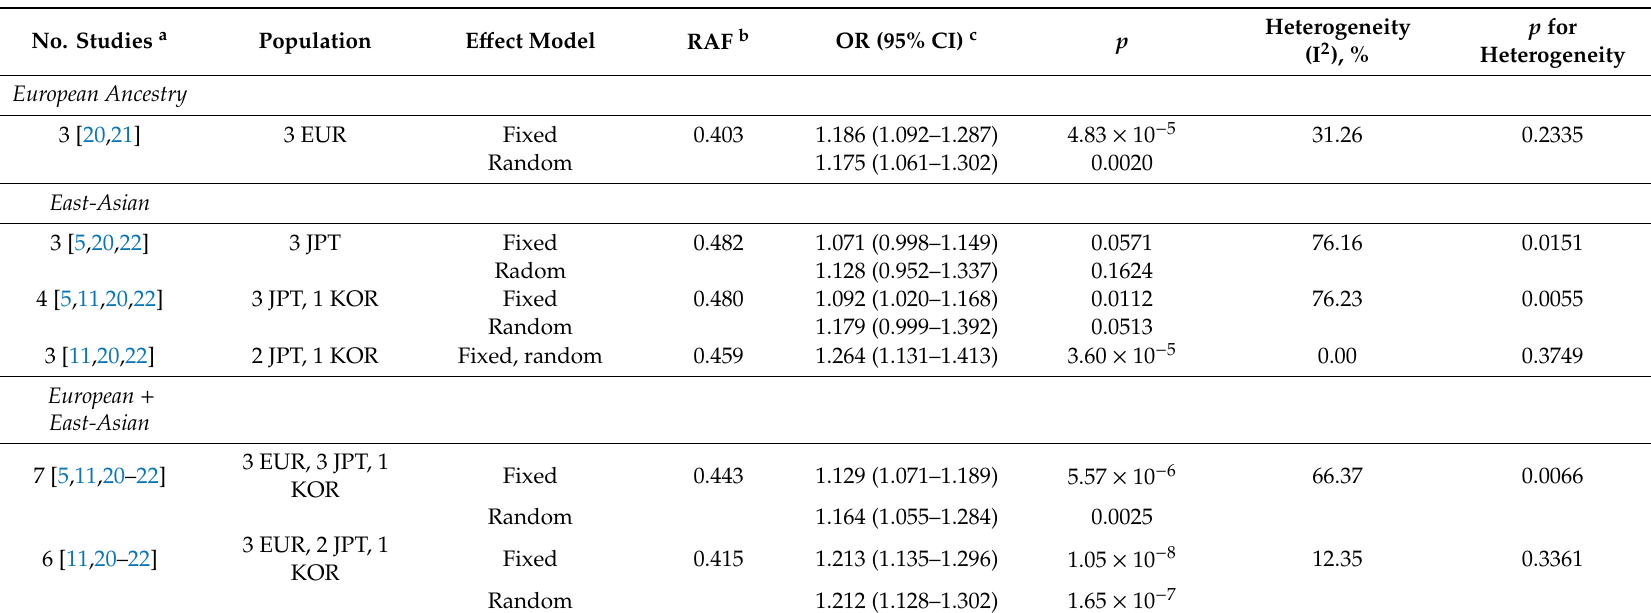
Table 2. rs700651 (2q33.1) in multi-ethnic